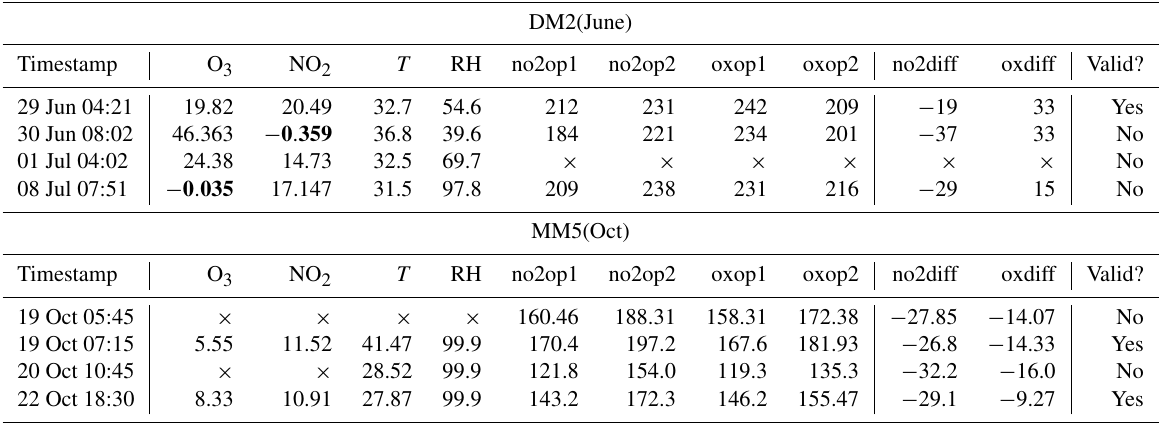
Table 1. Samples of the raw data collected from the DM2(June) and MM5(October) datasets. The last column indicates whether data from that timestamp were used in the analysis or not. Note that DM2(June) data, coming from site D, have samples at 1min intervals whereas MM5(October) data, coming from site M, have samples at 15min intervals. The raw voltage values (no2op1, no2op2, oxop1, oxop2) offered by the LCAQ sensor are always integer values, as indicated in the DM2(June) data. However, for site M deployments, due to averaging, the effective-voltage values used in the dataset may be fractional, as indicated in the MM5(October) data. The symbol × indicates missing values. A bold font indicates invalid values. Times are given in local